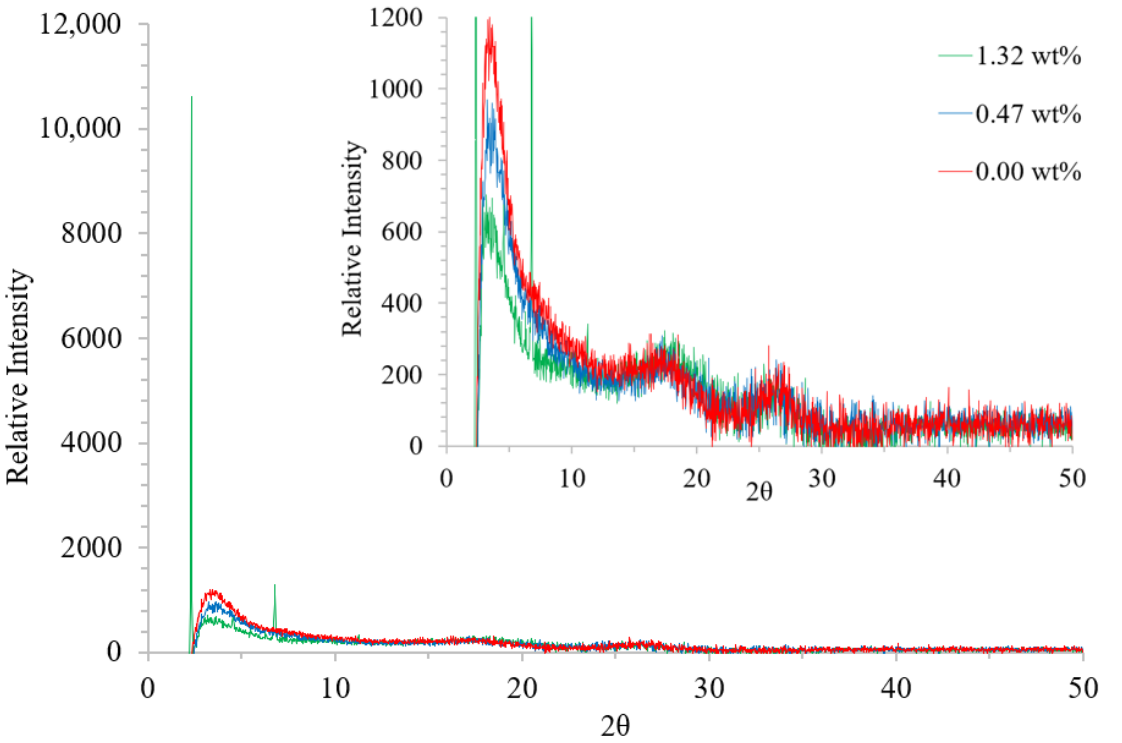
Figure 3. XRD traces showing the relative intensity of diffraction peaks for differing films. From bottom to top, traces are as follows: pristine PEDOT:PSS (red) and PEDOT:PSS/Tween 80 with 0.47 (blue) and 1.32 (green) wt% surfactant. Insert displays a close up of the smaller peaks.